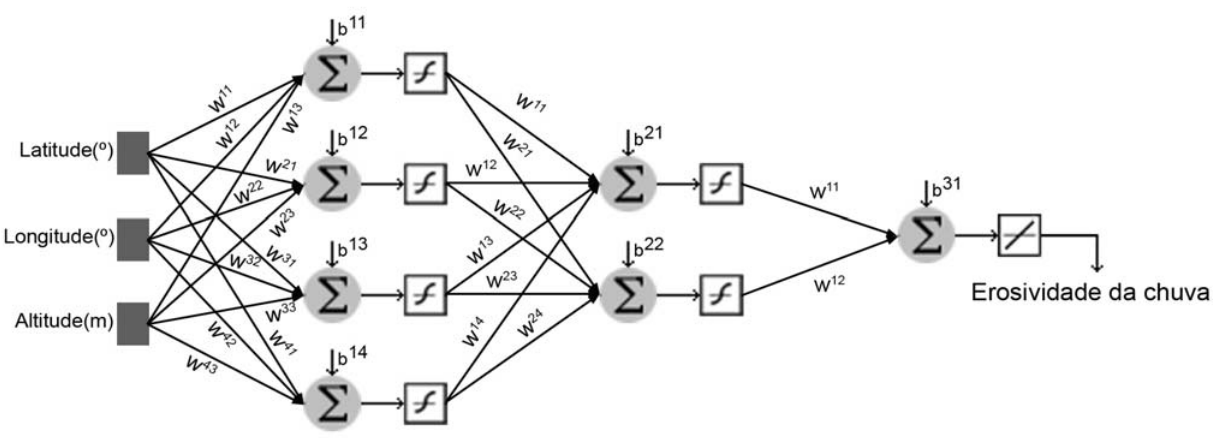
Figura 1. Exemplo de arquitetura 3-4-2-1 de uma rede neural artificial para estimativa da erosividade da